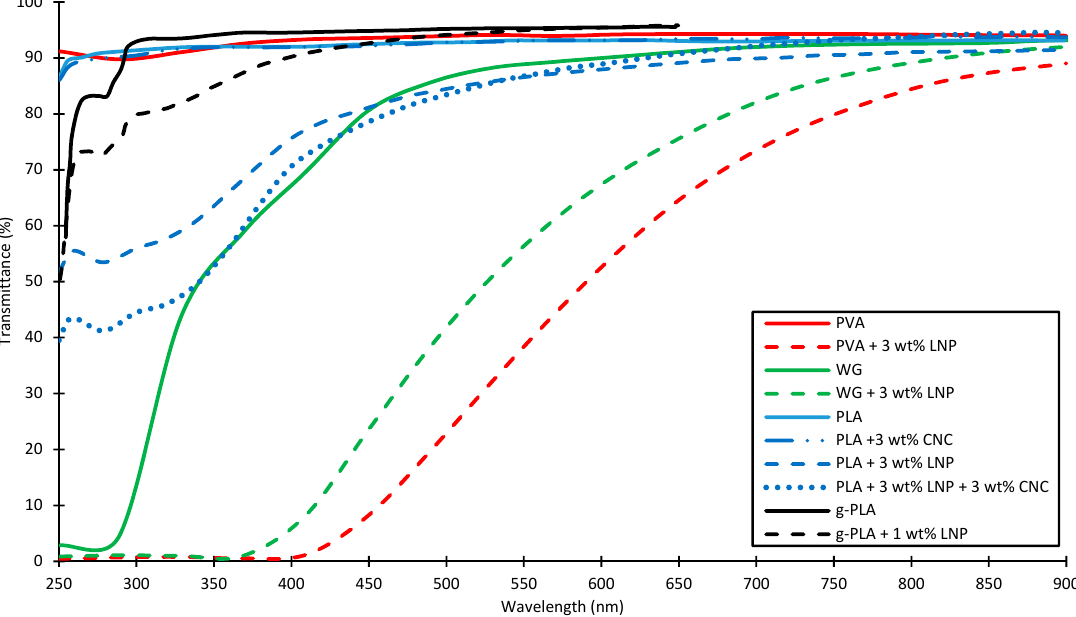
Figure 2. UV–Vis transmission spectra of Polyvinyl alcohol (PVA), Wheat gluten (WG) and Polylactic acid (PLA) polymer blend films with incorporated lignin nanoparticles (LNPs) and cellulose nanocrystals (CNCs). Adapted from [17,19,31,32], with permission from Elsevier.